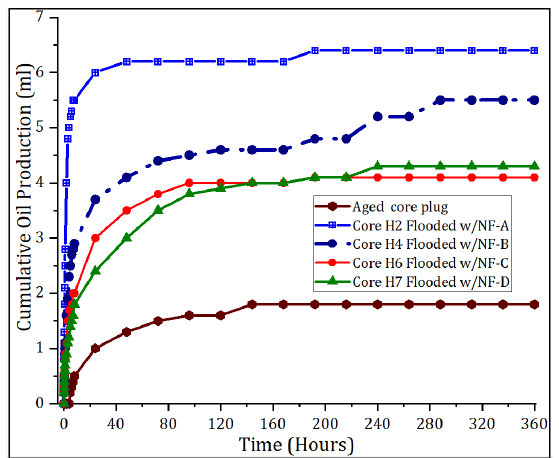
Figure 9. Spontaneous imbibition curves, before and after nanofluid core